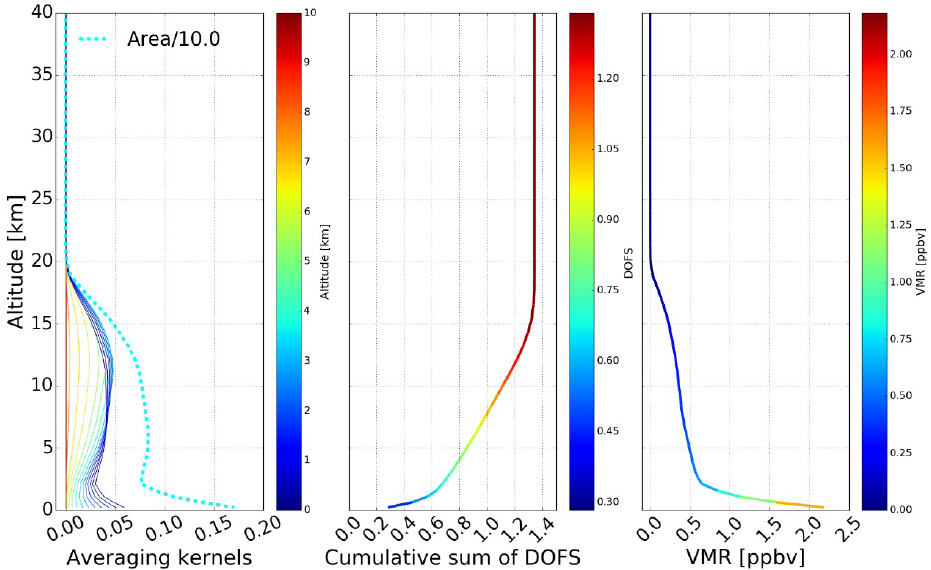
Figure 2. Averaging kernels, cumulative sum of degrees of freedom for signal (DOFs) and volume mixing ratio (VMR) profile of randomly selected HCHO retrievals at Hefei, eastern China.